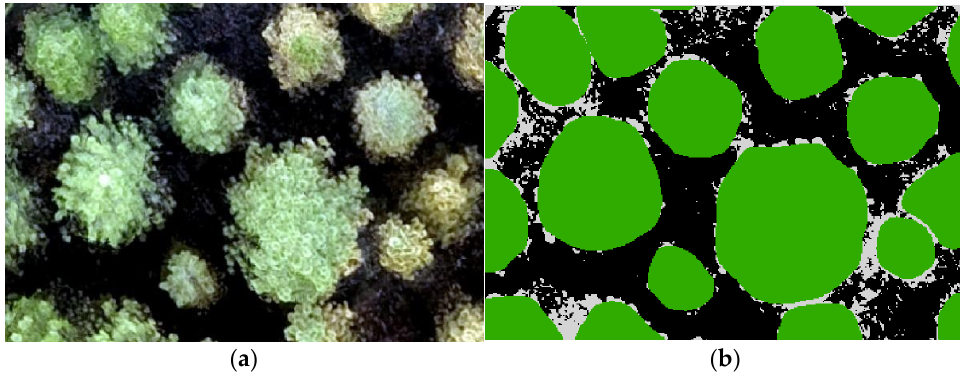
Figure 6. ( a ) Orthomosaic imagery from the Hoodoo fire. ( b ) Combined raster results with unburned surface represented by white, burned represented by black, and unburned canopy represented by green. Most of the surface pixels in ( b ) are noise caused by difference between the SVM unburned classification and the MR-CNN tree crown classification. Table 5. Calibration data, with the optimal unburned pixel cluster threshold that was selected highlighted in green and the results from the SVM surface burn classification in orange.